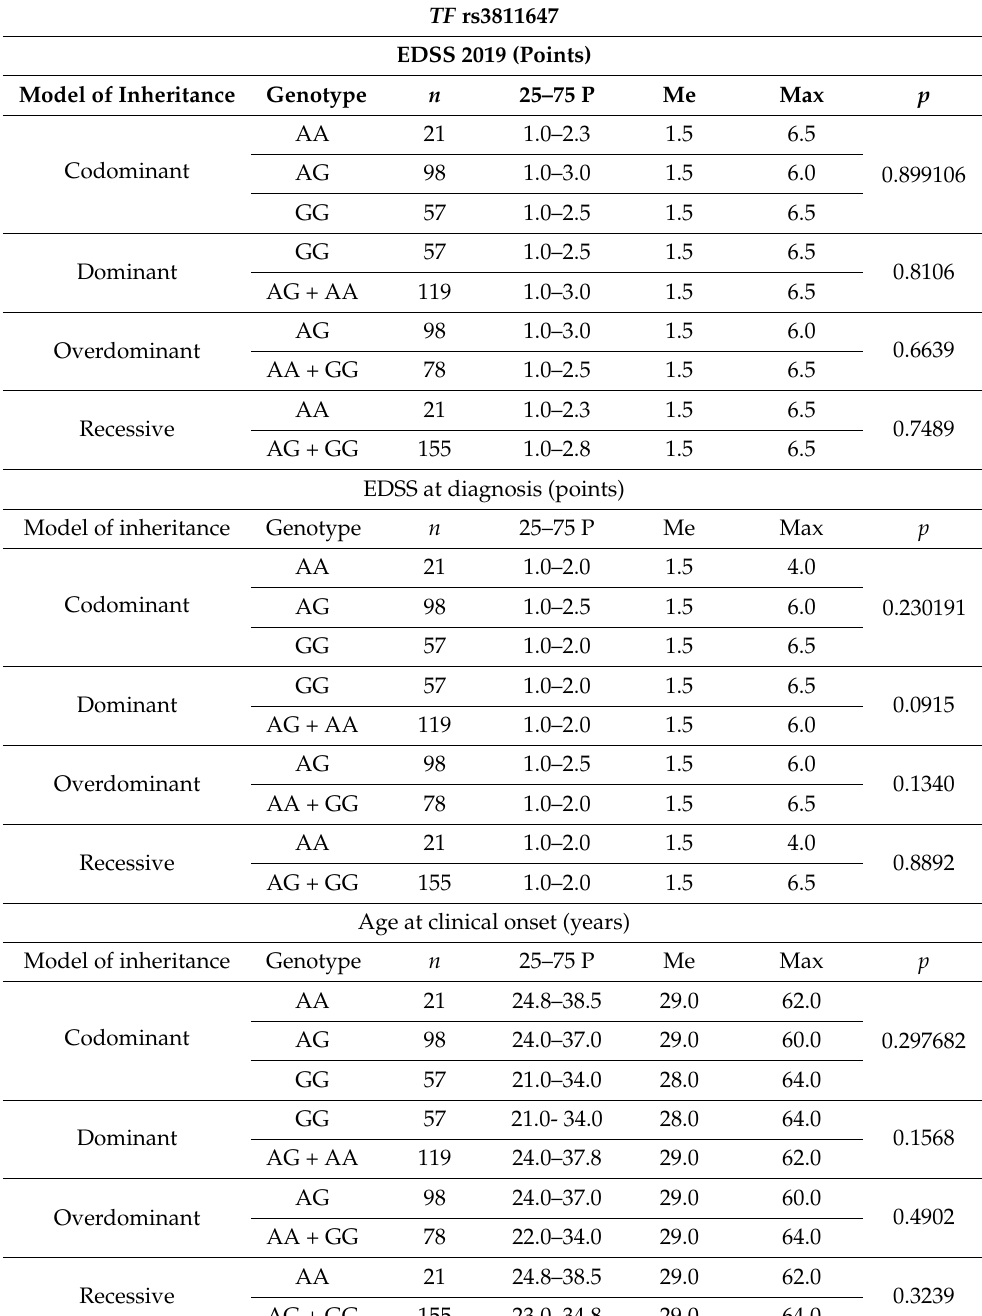
Table 5. Analysis of the relationship between the rs3811647 TF polymorphism and selected clinical